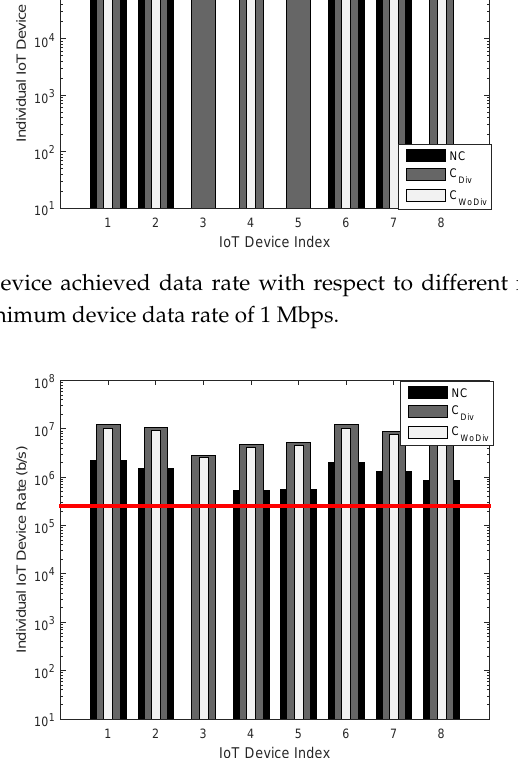
Figure 10. Individual device achieved data rate with respect to different number of total devices, with six relays and minimum device data rate of 250